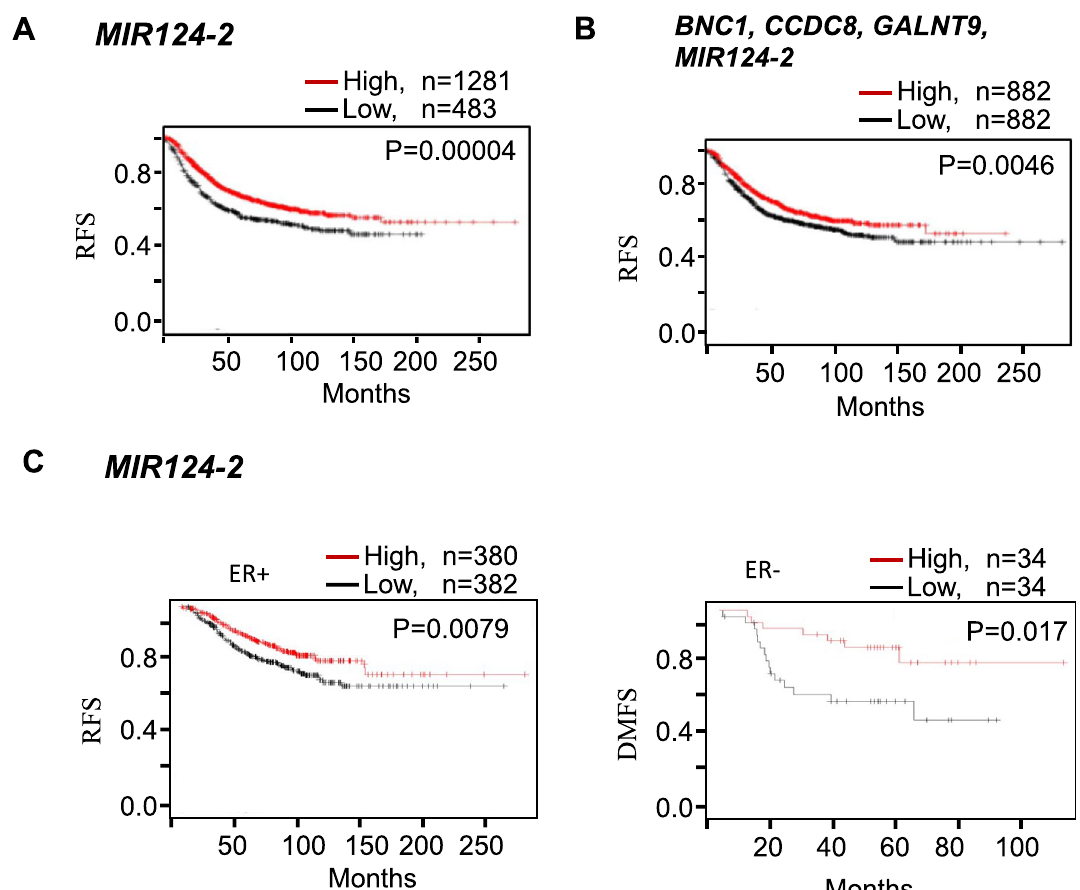
Figure 5. Loss of expression of BBM-hypermethylated genes (candidate metastasis suppressor genes) correlates with survival in breast cancer patients. ( A ) Kaplan–Meier analysis shows that low expression of MIR124-2 correlates to poor relapse free survival (RFS) of breast cancer patients (p = 0.00004). ( B ) Kaplan–Meier analysis using a combined four-metastasis suppressor gene signature ( BNC1 , CCDC8 , GALNT9 and MIR124-2 ) shows that loss of expression of these genes in combination correlates to poor RFS of breast cancer patients ( p = 0.0046). (C) Low expression of MIR124-2 is associated with poor prognosis of ER + and ER- breast cancer patients (p = 0.007 and 0.017